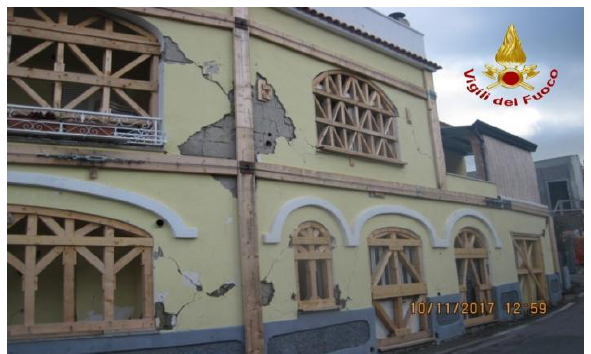
Figure 18. Examples of wooden planking for windows